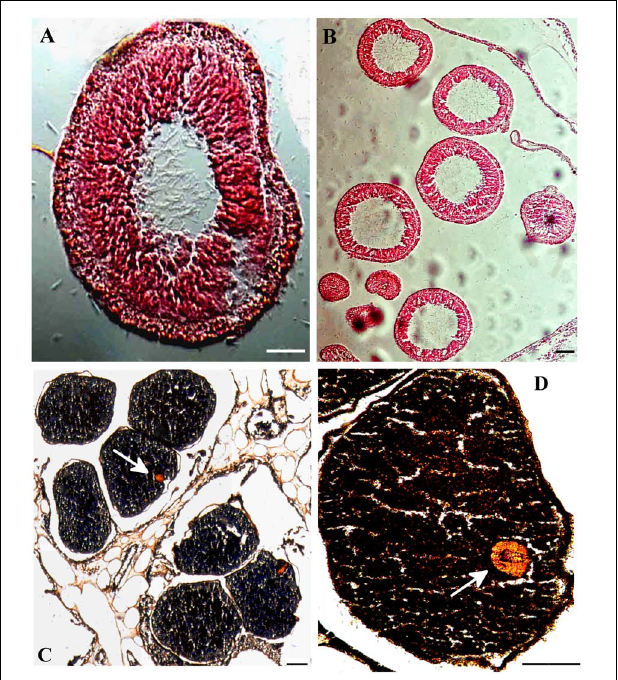
section in colony with a mature spermary featuring spermatids in its periphery (June 2016) (B) Cross-section of a male colony showing mature and immature spermaries, featuring spermatids oriented to the center of the spermaries (June 2016) (C, D) Sagittal sections in colony, with mature oocytes featuring a nucleus in their periphery. White arrow points toward the nucleus (July 2016). Scale bars = 100 µ